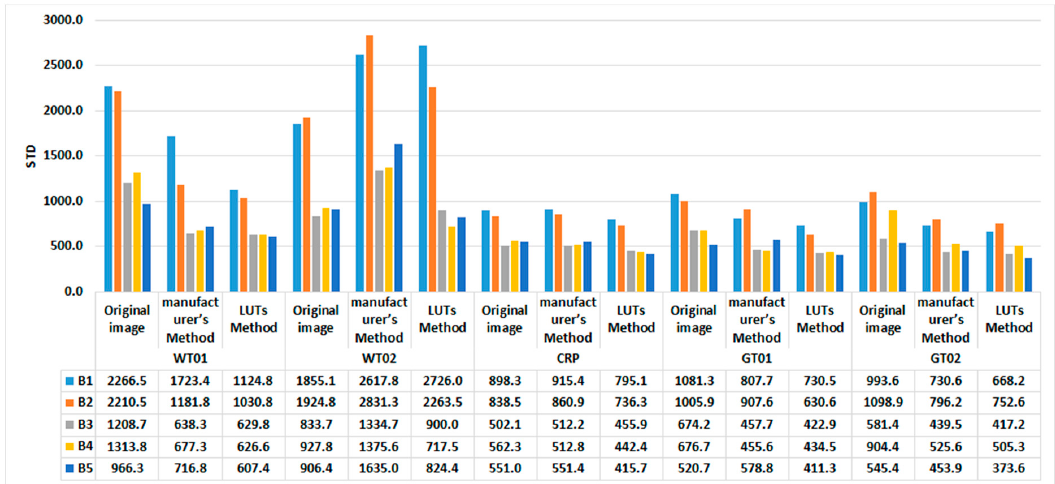
Figure 21. STD of DN of targets in the original image and image corrected by the two calibration